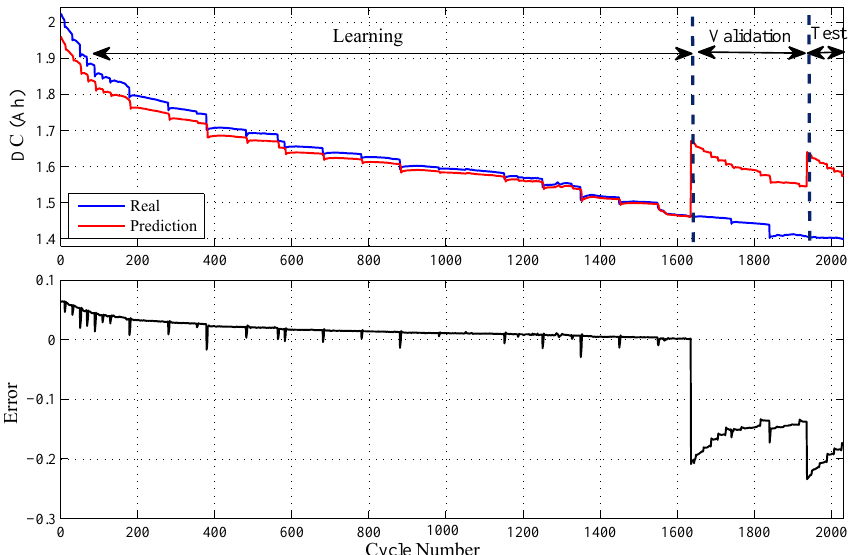
Figure 6. Evolution of real and estimated DCs of the BPLM algorithm.